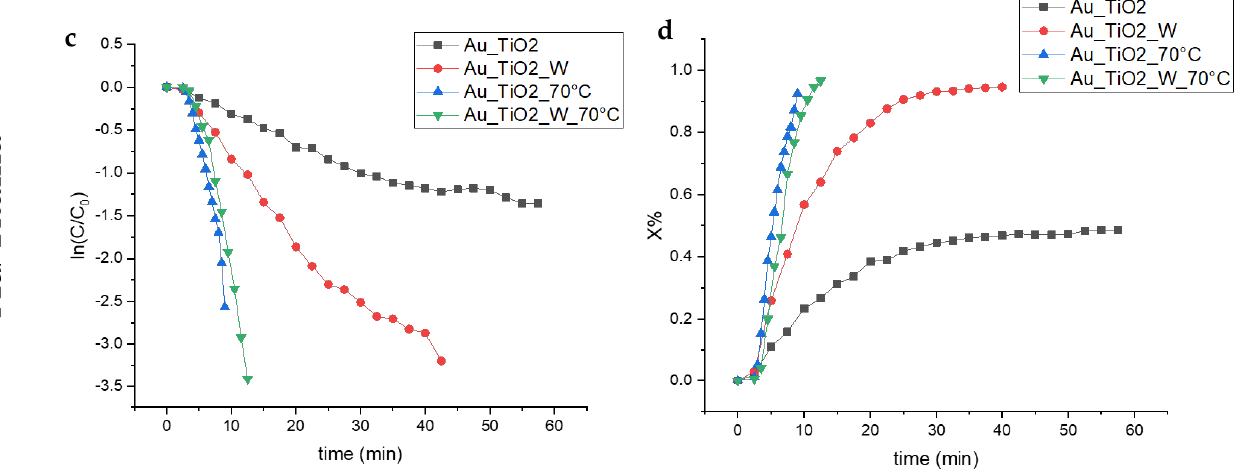
Figure 12. Kinetic performances in 4-NP reduction of the washed and unwashed catalysts supported on either active carbon ( a , b above) or titania ( c , d ) at room temperature and at 70 °C.